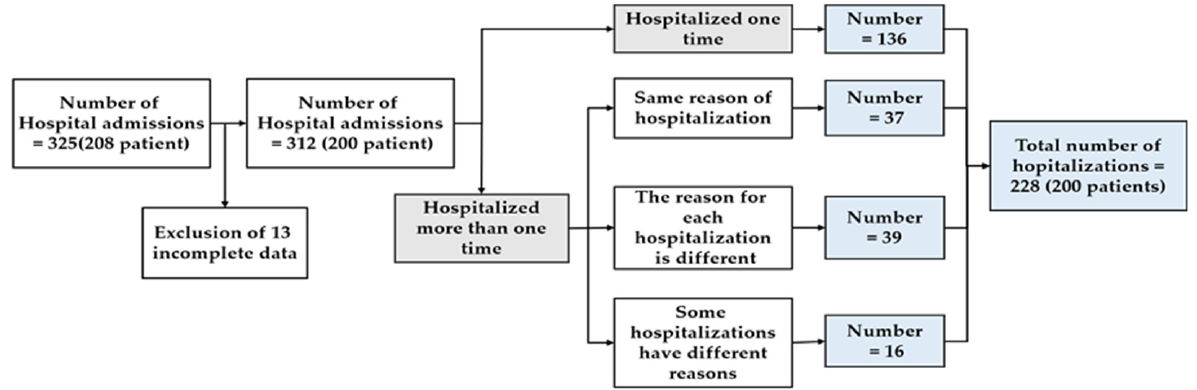
Figure 1. Subject identification process.